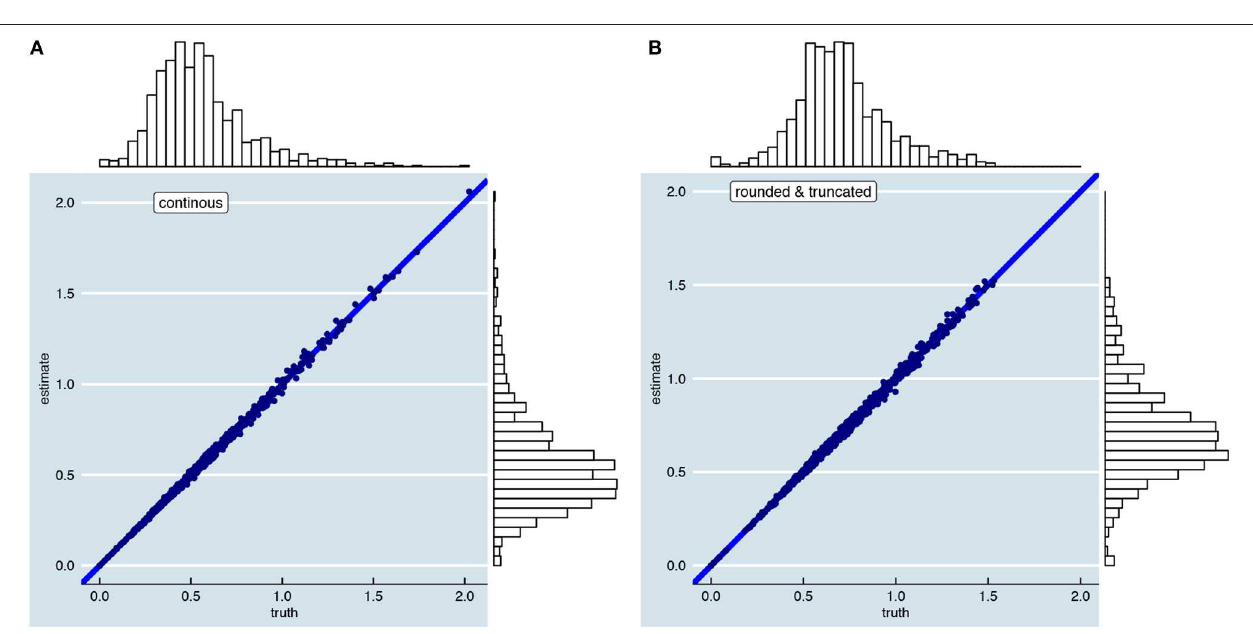
FIGURE 10 | Visualization of unbiasedness of the person-specific SEm over 10,000 repeated test takes. The left figure (A) is based on continuous parallel test scores; the right figure (B) on rounded and truncated test scores. The two figures are examples of a test with 12-items, K = 2, a reliability of 0.8 and a relationship between “true” score and error variance as shown in Figure 5B